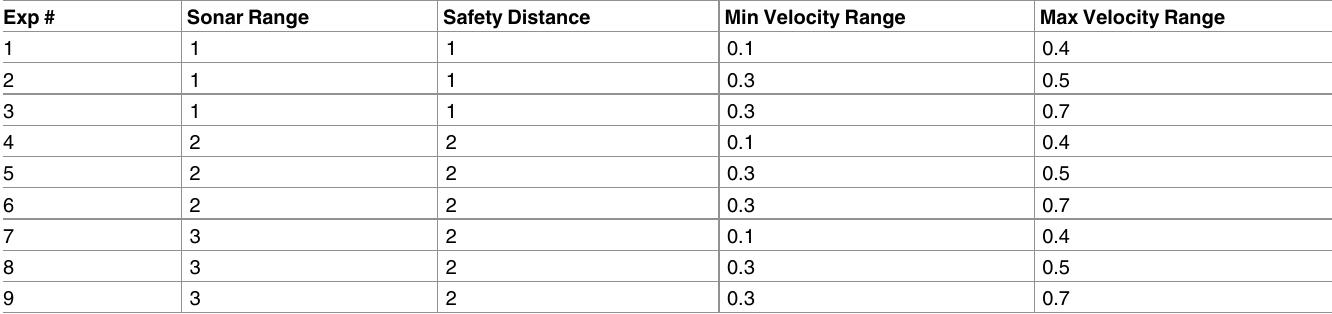
Table 3. Test cases to find optimal safety distances and sonar